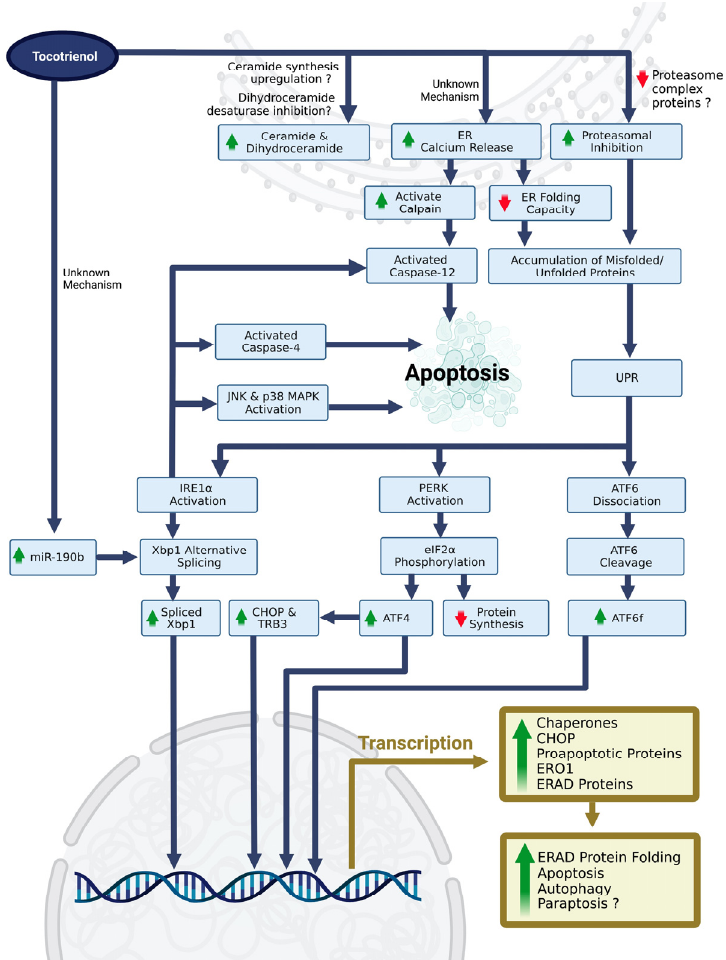
Figure 4. Reported and postulated molecular mechanisms of tocotrienol-mediated ERS and ERS- related cell fate. Abbreviations: ATF4, activating transcription factor 4; ATF6, activating transcription factor 6; ATF6f, ATF6 fragment or cleaved form; CHOP, CAAT/enhancer-binding protein homologous protein; eIF2 α , eukaryotic initiation factor 2 α subunit; ER, endoplasmic reticulum; ERAD, ER- associated degradation; ERO1, ER oxidoreductin 1; IRE1 α , inositol requiring element 1 α ; JNK, c-Jun N-terminal kinase; MAPK, mitogen-activated protein kinase; PERK, protein kinase-like endoplasmic reticulum kinase; TRB3, tribbles 3; UPR, unfolded protein response; Xbp1, X-box binding protein 1. The figure was created by authors using BioRender.com on 21 March